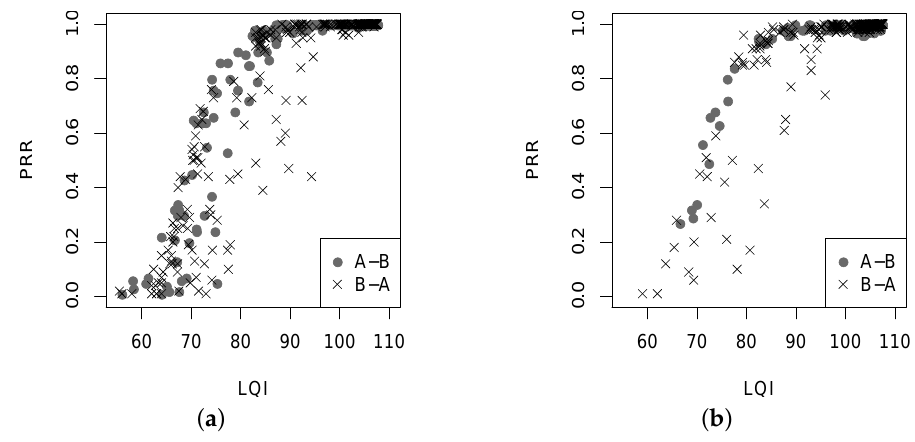
Figure 11. The PRR versus LQI under two different forest environments. ( a ) Bajia; ( b )